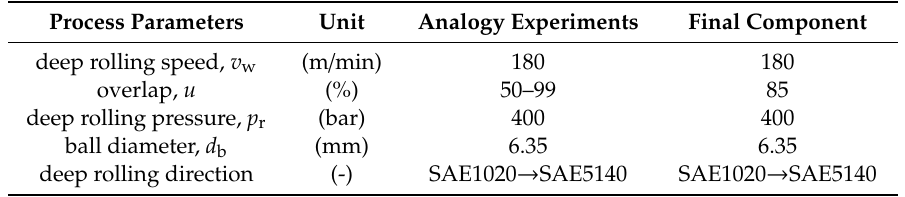
Table 2. Process parameters of the deep-rolling